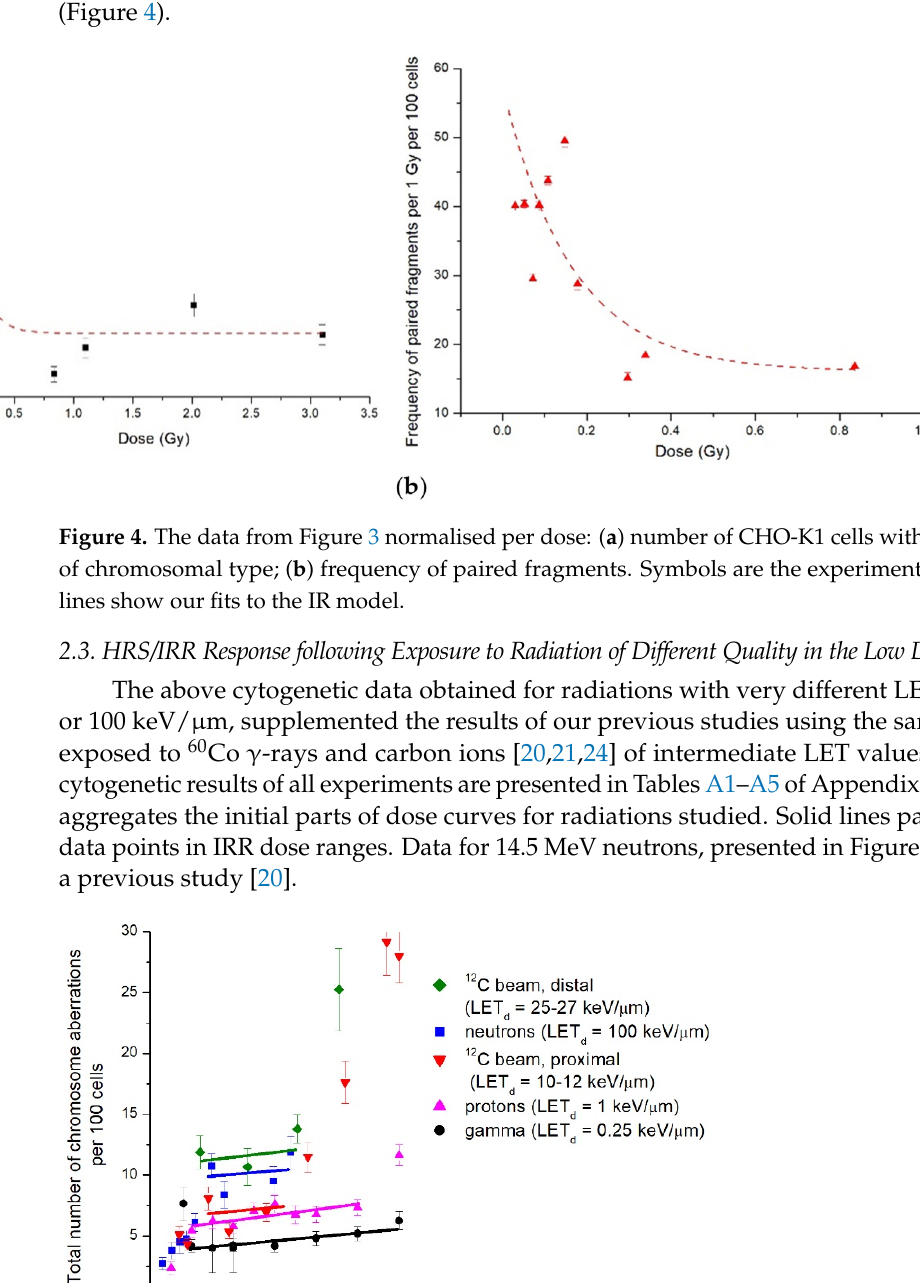
Figure 3. Cytogenetic effects in CHO-K1 cells induced by 14.5 MeV neutrons: ( a ) number of cells with aberrations of chromosome type; ( b ) frequency of paired fragments. Symbols are experimental data; solid lines are LQ model approximations, whereas dash line shows our fit to the data of the IR model.